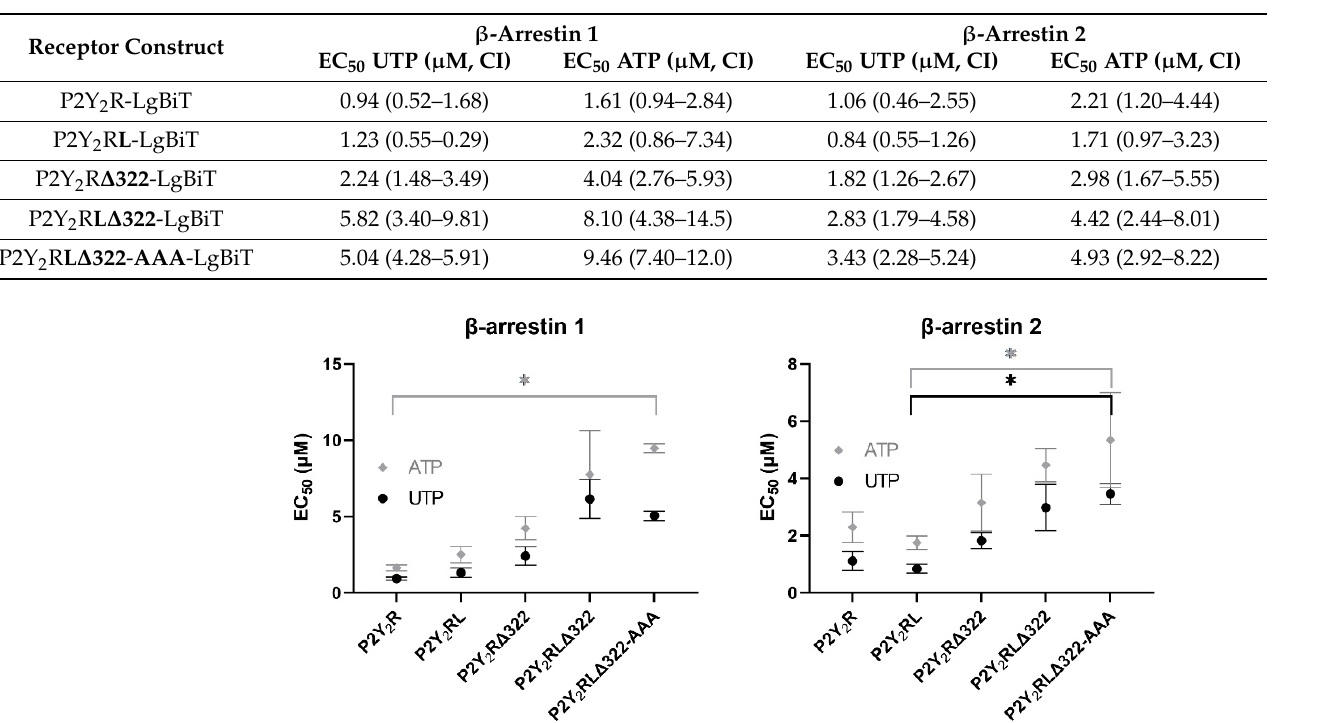
Table 1. EC 50 values, as a measure of the potency of either UTP or ATP to induce the recruitment of β arr1 or β arr2 to the (modified) P2Y 2 R constructs in the NanoBiT ® system. Data are from three independent experiments, each performed in duplicate. CI: 95% confidence interval.